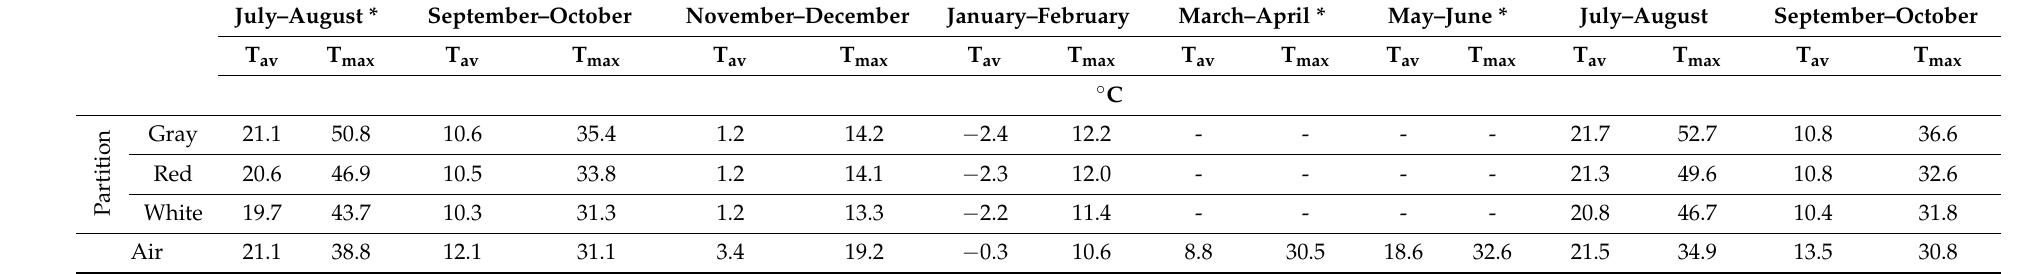
Table 1. Average and maximum surface temperatures of the partition for the period of 1 July 2017–31 October